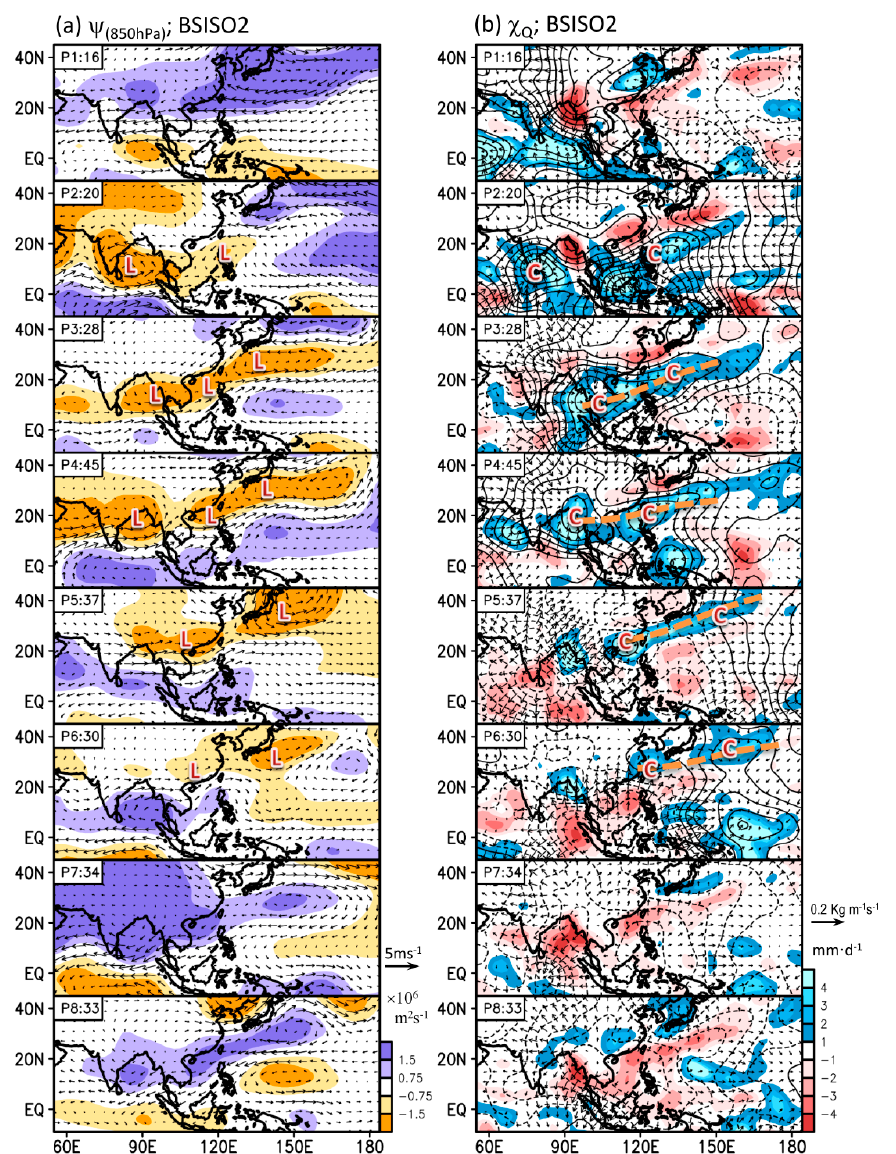
Figure 6. ( a ) The composite daily anomalies (MJ mean removed) of 850-hPa wind vectors and related stream function ( ψ ; shaded) for each phase of BSISO2 during May and June 2014 to 2017. The information of the phases (P1 to P8) and days for composites is provided in the top left. “L” indicates the movement of the cyclonic system discussed in the manuscript. ( b ) is corresponding to ( a ), but for the composite daily anomalies of the potential function of vertical integrated moisture flux ( χ Q ) and related rain rate (shaded) for each phase of BSISO2. The movement of the convergence line (marked by dashed line), and the convergence centers (marked by “C”), that are discussed in the manuscript are added. The contour interval is 0.15 × 10 7 kg s − 1 .